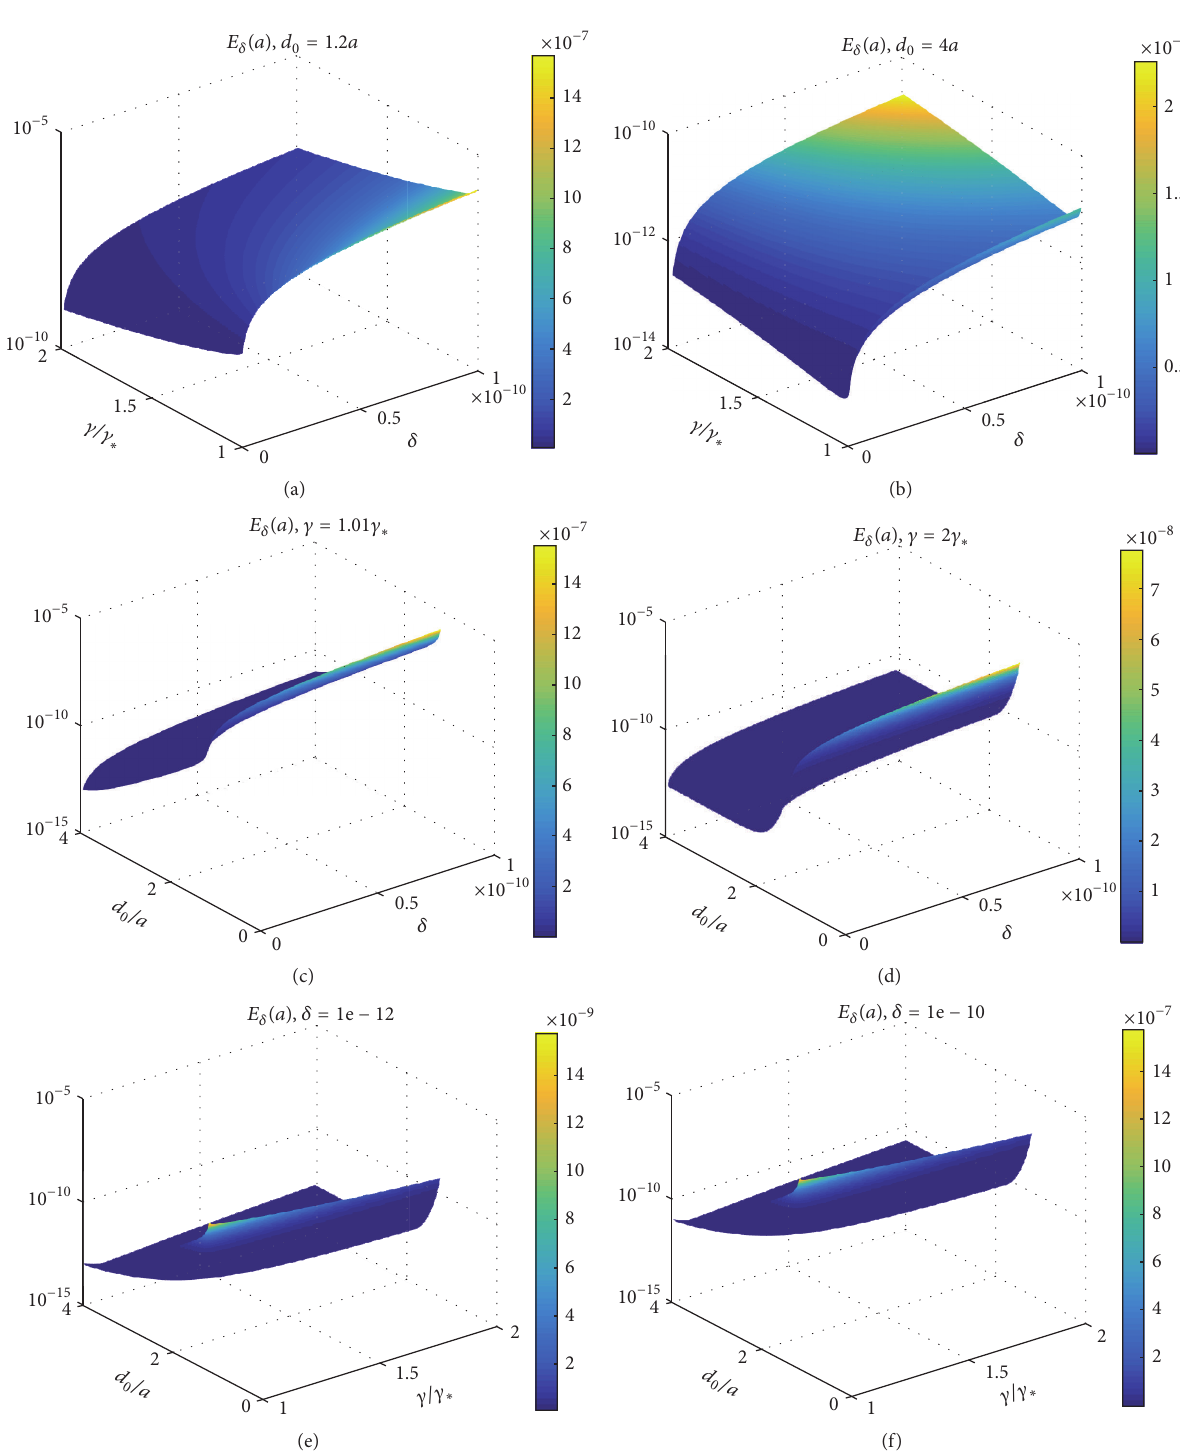
Figure 3: These are plots of 𝐸 𝛿 (𝑎) as a function of (a) 𝛿 and 𝛾 ( 𝑑 0 = 1.2𝑎 ); (b) 𝛿 and 𝛾 ( 𝑑 0 = 4𝑎 ); (c) 𝛿 and 𝑑 0 ( 𝛾 = 1.01𝛾 ∗ ); (d) 𝛿 and 𝑑 0 ( 𝛾 = 2𝛾 ∗ ); (e) 𝛾 and 𝑑 0 ( 𝛿 = 10 −10 ); (f) 𝛾 and 𝑑 0 ( 𝛿 = 10 −12